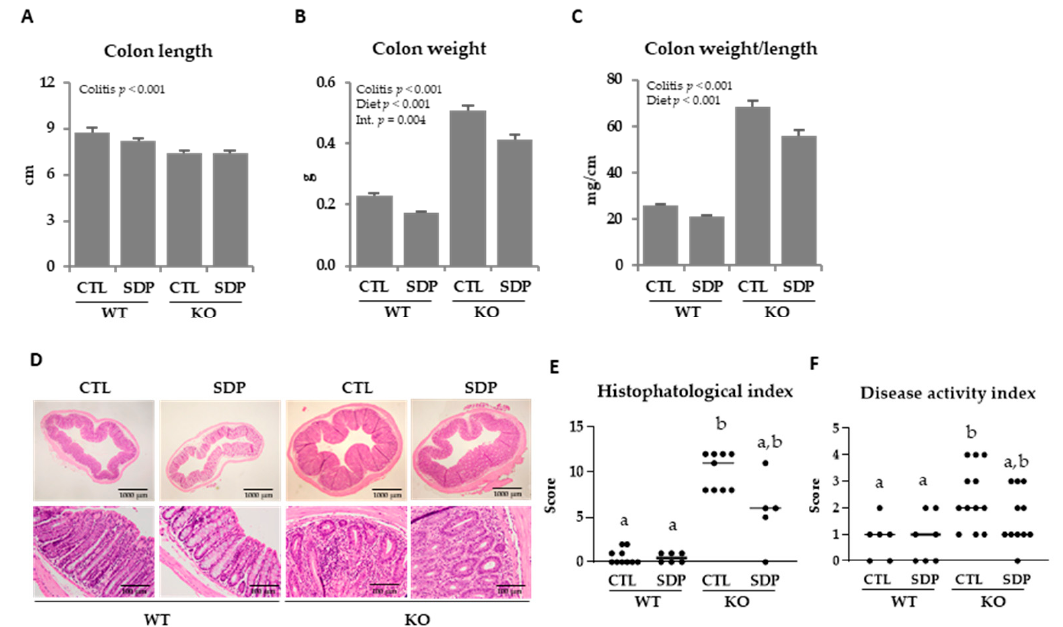
Figure 1. Effects of spray-dried porcine plasma (SDP) supplementation on colon morphology in Mdr1a knockout (KO) mice. ( A ) Colon length. ( B ) Colon weight. ( C ) Ratio between colon weight and colon length. ( D ) Representative images of hematoxylin and eosin staining from a histopathological study of the colonic mucosa. Top images were taken at low magnification (×2), whereas bottom images were taken at high magnification (×20). ( E ) Histopathological index. ( F ) Disease activity index. In panels A to C, results are expressed as mean ± SEM ( n = 6–9 mice/group). In panels D and E, results are expressed as median ( n = 5–12 mice/group). Means without a common letter differ, p < 0.05. CTL, control; Int, indicates the interaction between colitis and diet.